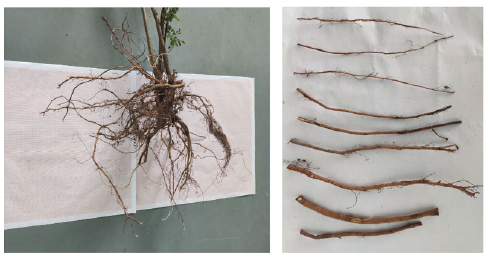
Figure 1: Root diagram of tailing pond